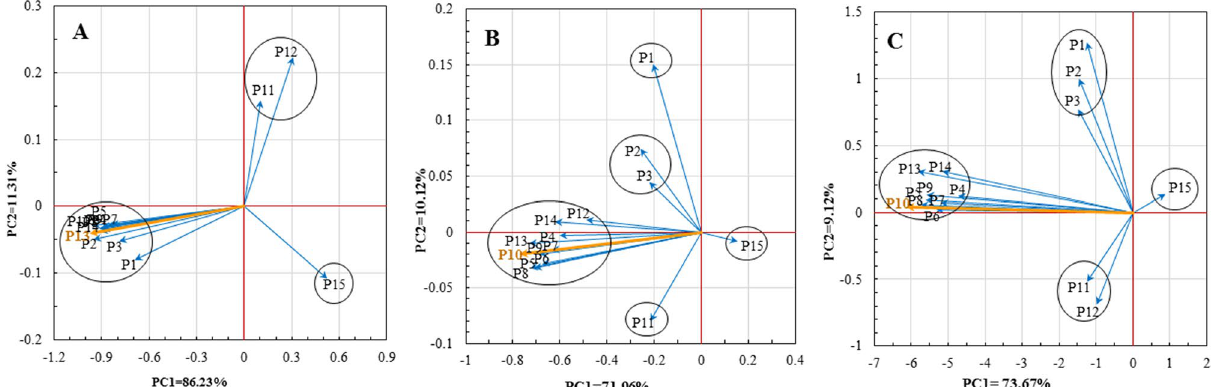
Figure 8. Principle component biplot of JIP test parameters based on variations of 5 levels of light spectra under ( A ) control (non-stress); ( B ) salinity stress; ( C ) alkalinity stress. P1: ABS/RC; P2: Dio/RC; P3: TRo/RC; P4: Eto/RC; P5: REo/RC; P6: φP O ; P7: ΨE O ; P8: φE O ; P9: δR O ; P10: φR O ; P11: PI ABS ; P12: PI total ; P13: V j ; P14: V i ; P15: